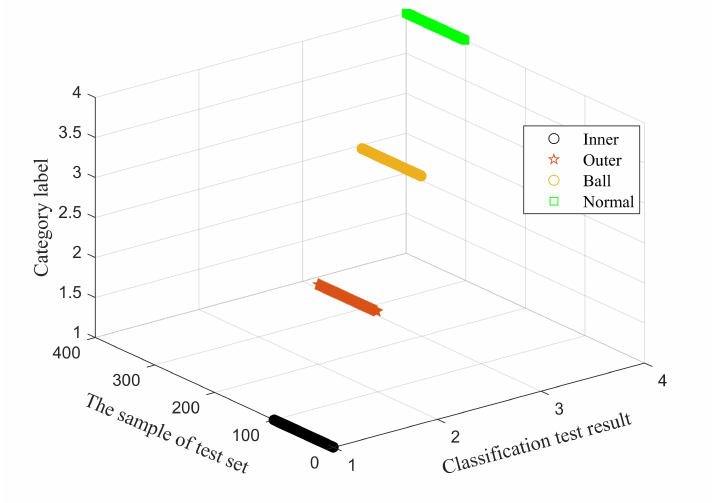
Figure 15. Test results of the DBN model classification accuracy after signal